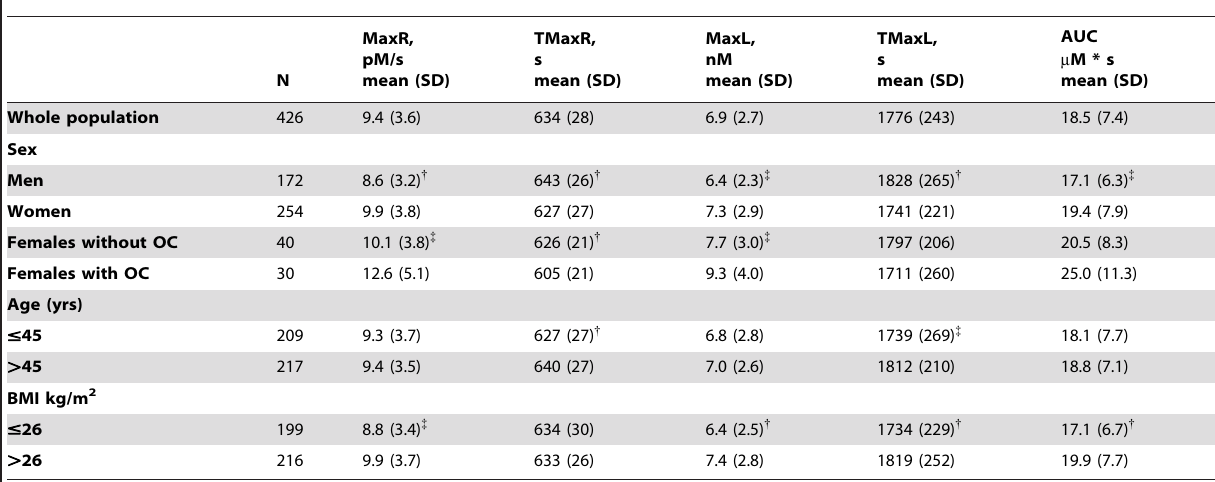
Table 3. Factor Xa generation outputs for individuals with a known